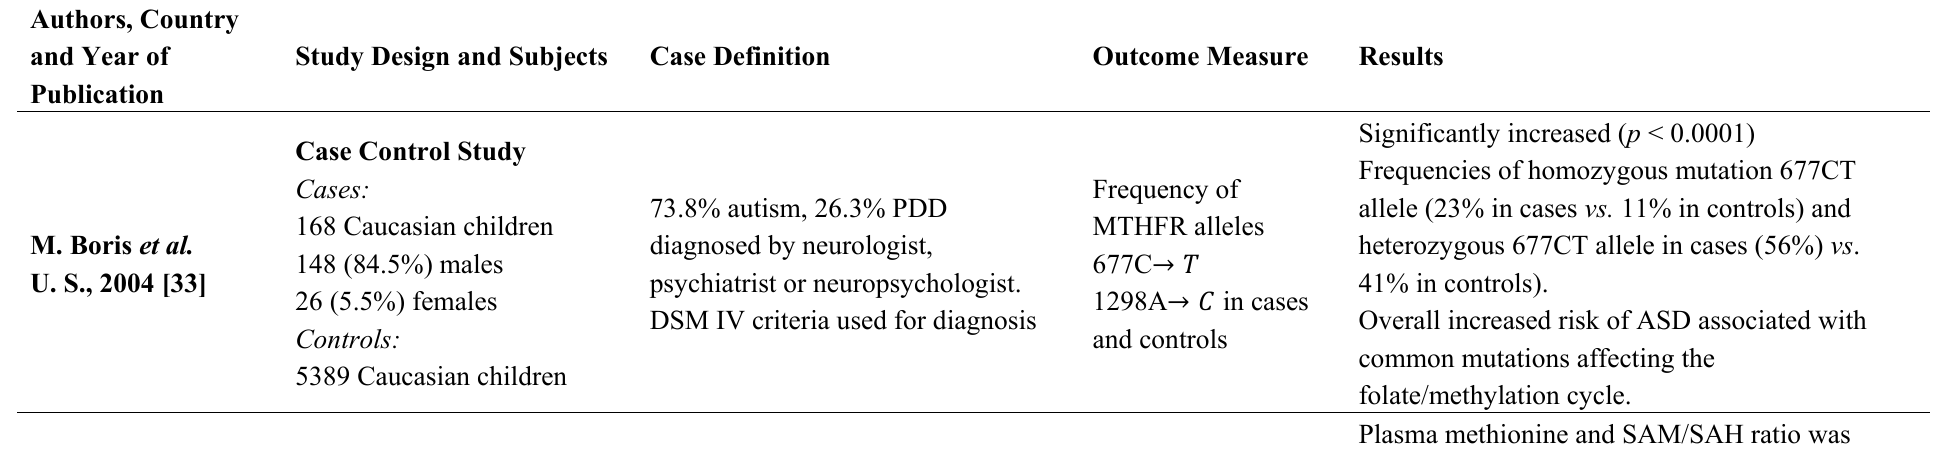
Table 1. Association between maternal folate intake, folate/folate metabolites, gene polymorphism and autism spectrum disorders